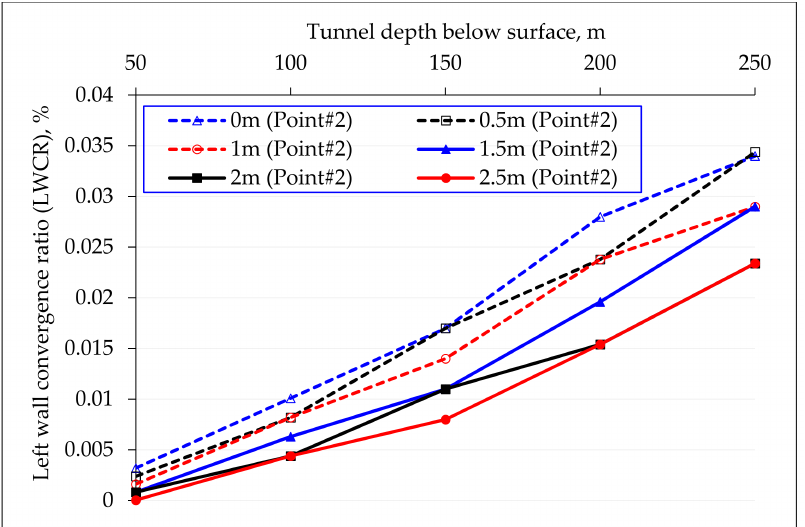
Figure 16. Convergence ratios of tunnel left wall (LWCR) at various tunnel depths below surface measured at different lateral distances from (e.g., reference point #2) the tunnel